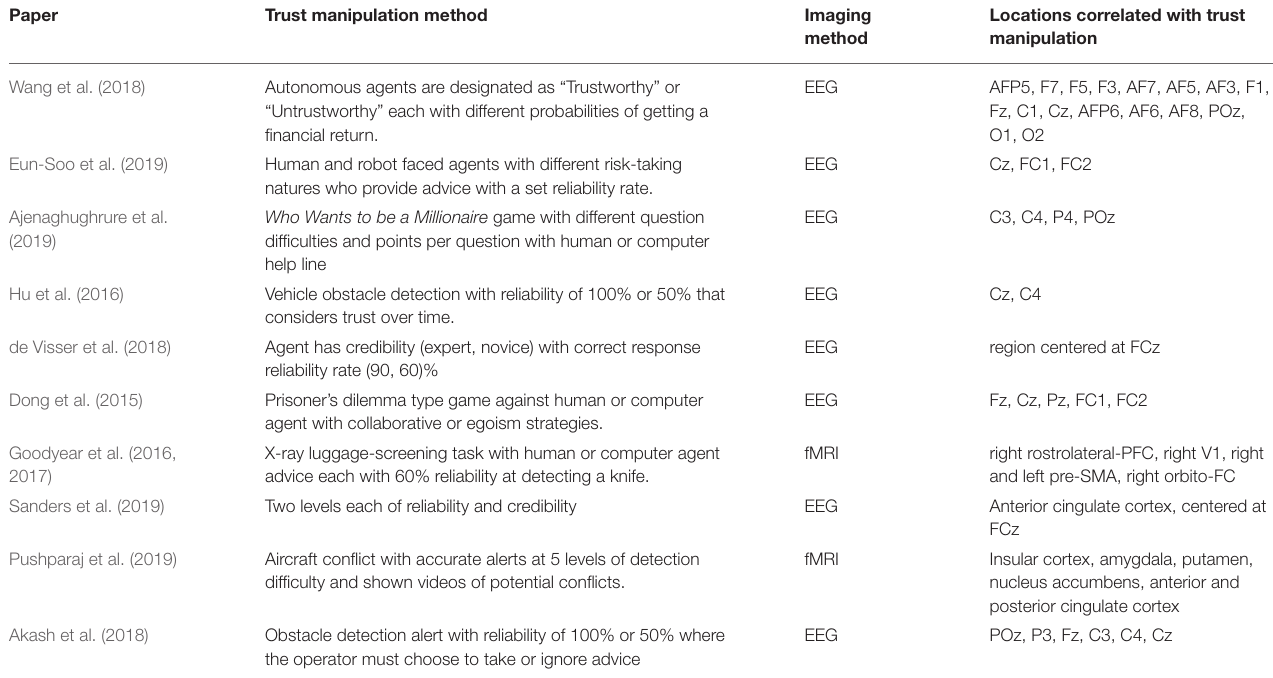
TABLE 3 | Summary of neural correlates of trust in technology domains.